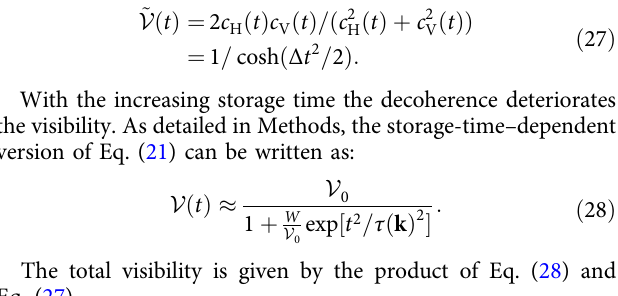
Fig. 4 Persistence of high mean visibility. Visibility has been averaged ; y ; t Þi over wavevector modes h V ð x for increasing memory times t . s s x s ; y s a Blue curve represents the fraction of modes violating CHSH inequality, while the red curve corresponds to the visibility averaged over this subset of modes. b Visibility averaged over all modes (purple curve) yields good agreement with the model based on Glauber cross-correlation g (2) (red dashed curve, cf. Eq. (20)). Lines between points serve as guide to the eye. Errorbars represent extreme cases in the ensemble of wavevector-modes, with top/bottom of errobar corresponding to the best/worst visibility ± 1 s. d. obtained from the fi